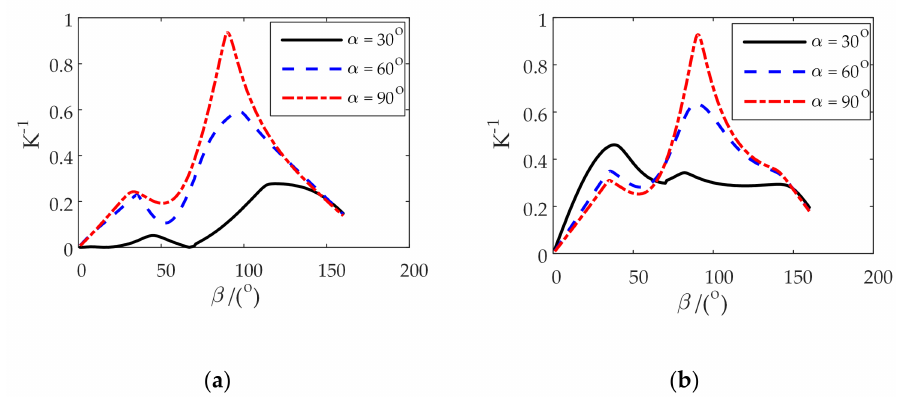
Figure 14. Curve of the reciprocal of the condition number and uplift angle. ( a ) γ = 60 ◦ ; ( b ) γ = 90 ◦